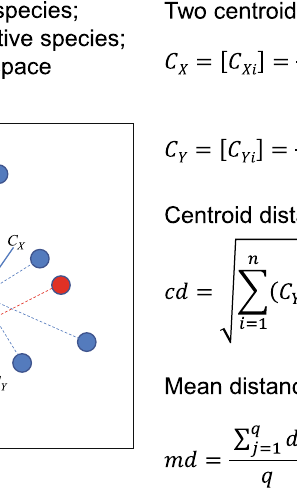
(triangles) are the centroids of the p native species and q non-native species, with [ C X i ] and [ C Yi ] representing the coordinates of the centroids according to all traits, i.e.,[ C X1 , C X2 , … , C Xn ],[ C Y1 , C Y2 , … , C Yn ].Here, C X =[ C X i ]and C Y =[ C Yi ],where C Xi and C Yi are the mean value of trait i for native and non-native species. cd is the distance between the centroids for native ( C X ) and non-native ( C Y )